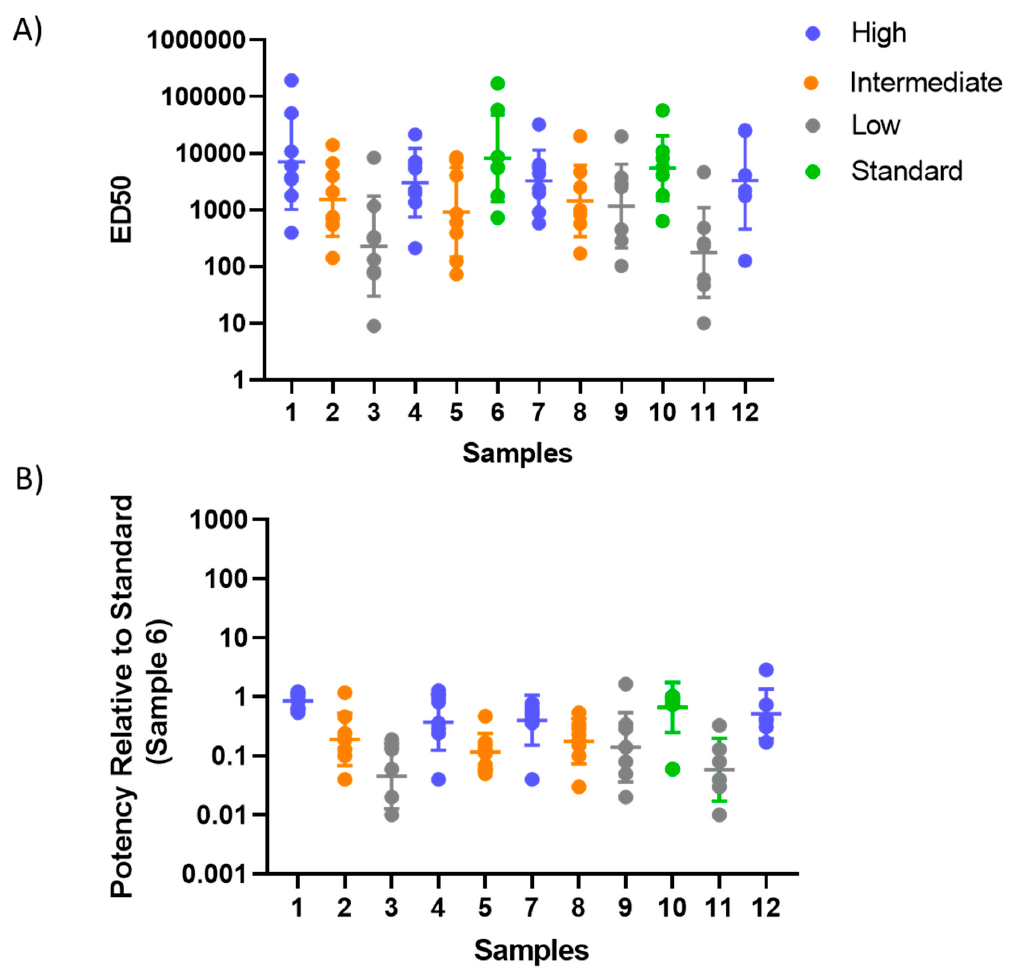
Figure 4. Geometric mean ED50 (50% effective dilution corresponding to a half-maximal assay response) and relative potency estimates. ED50 ( A ) and relative potency ( B ) estimates are shown for all samples ( n = 11) and laboratories ( n = 8). Each dot represents a geometric mean estimate for one sample and one laboratory. The same data are shown in Supplementary Tables S4 and S5 and Supplementary Figure S3. Table 2. Inter-lab variability: Fold-change of laboratory geometric mean ED50 estimates from the overall study median ED50 estimate for each sample.